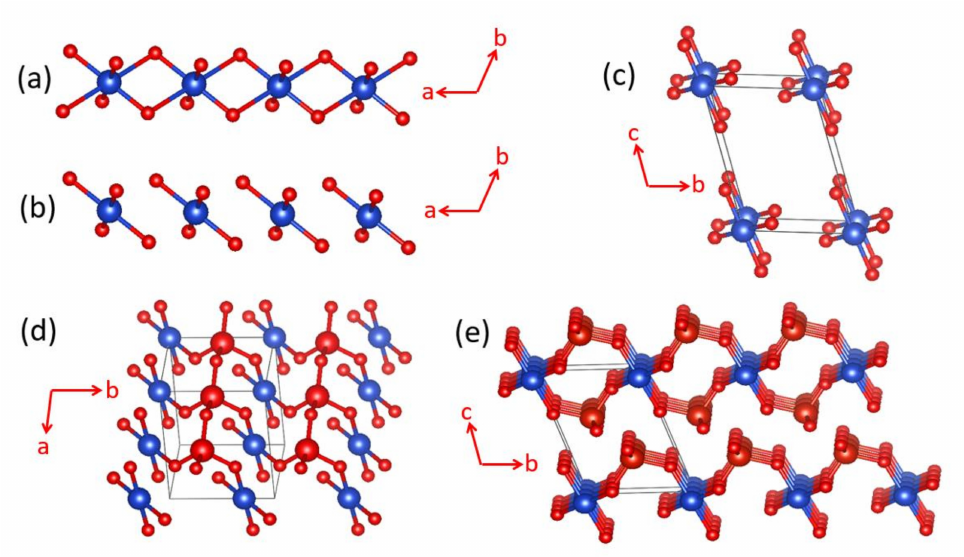
Figure 11. Crystal structure of α -CuV 2 O 6 , where the blue spheres represent the Cu atoms, and the large and small red spheres the V and O atoms, respectively: ( a ) A CuO 4 chain along the a-direction, which is made up of edge-sharing, axially-elongated, CuO 6 octahedra. ( b ) A stack of CuO 4 square planes along the a-direction, which results from the chain of edge-sharing CuO 6 octahedra by removing the axial Cu-O bonds. ( c ) Stacks of CuO 4 square planes running along the c-direction. ( d ) One sheet of CuO 4 stack chains parallel to the a–b plane condensed with chains of corner-sharing VO 4 tetrahedra on one side of the sheet. ( e ) Stacking of CuV 2 O 6 layers forming α -CuV 2 O 6 .